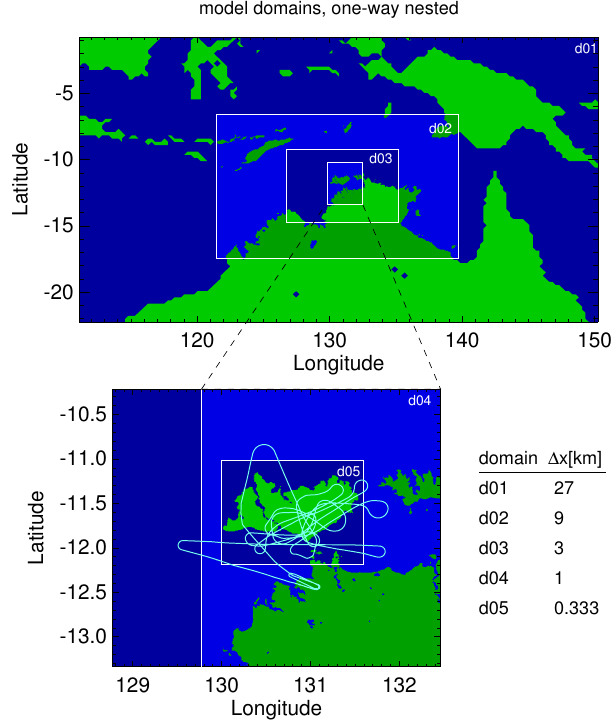
Figure 2. Location of model domains and their horizontal grid spac- ing. The Geophysica flight path is superimposed in light